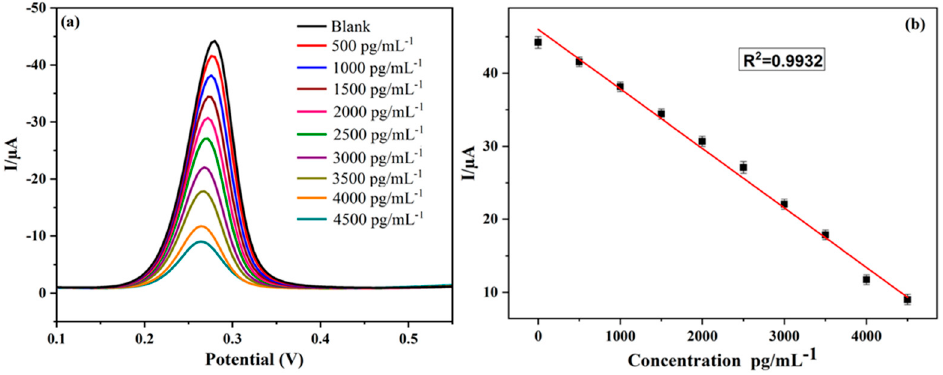
Figure 3. ( a ) Di ff erential pulse voltammograms of Anti-IL8/MoS 2 /ZnO composite modi fi ed GCE Figure 3. ( a ) Differential pulse voltammograms of Anti-IL8/MoS 2 /ZnO composite modified GCE electrodes recorded in di ff erent concentrations of IL8 range from 500 pg to 4500 pg. ( b ) A linear electrodes recorded in different concentrations of IL8 range from 500 pg to 4500 pg. ( b ) A linear relationship between peak currents against concentrations of IL8. relationship between peak currents against concentrations of IL8.